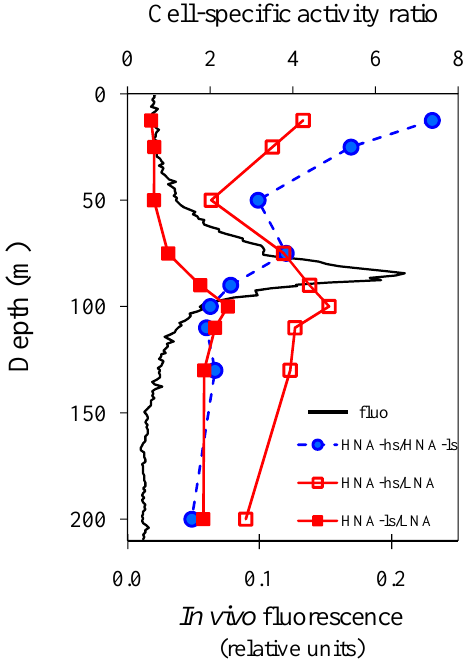
Fig. 5. Vertical distribution of ratios of cell-specific activities (HNA-hs to LNA, HNA-ls to LNA and HNA-hs to HNA-ls) and in vivo fluorescence at station